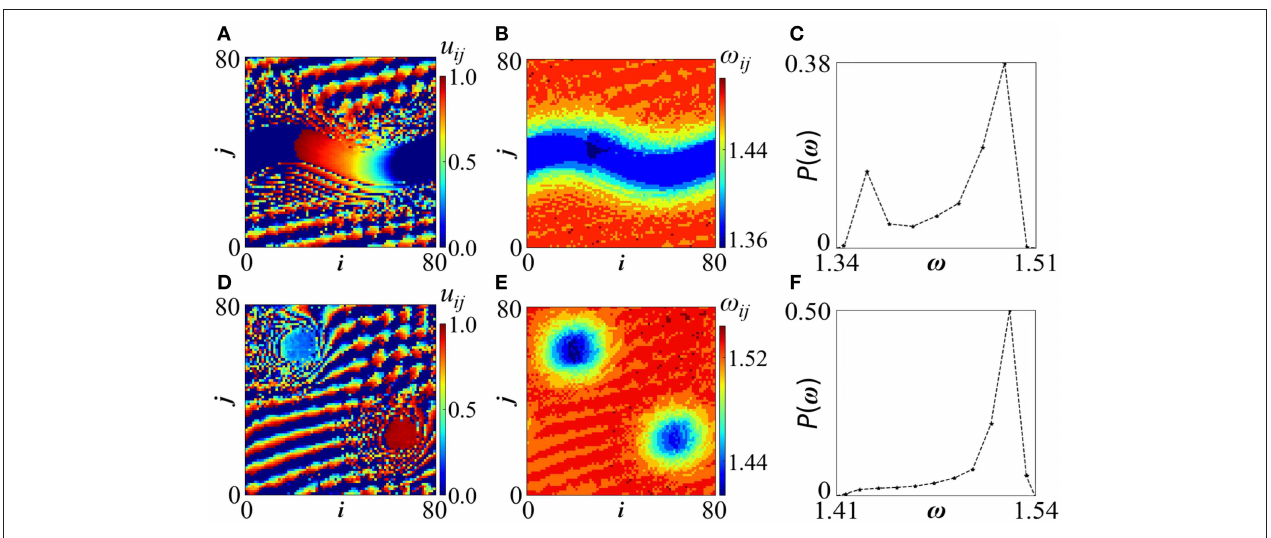
FIGURE 8 | Random hierarchical connectivity in LIF model. Top row: Stripe chimera for parameters σ = 0.22, T r = 2.0. (A) u ij -profiles, (B) ω ij -profiles and (C) distribution of ω -values. The P ( ω ) spectrum present two distinguishable maxima: one at the high ω -region which correspond to the traveling waves with short wavelength and one in the low ω -values associated with the stripe. Bottom row: Double coherent spot chimera for σ = 0.26 and T r = 2.0. (D) u ij -profiles, (E) ω ij -profiles and (F) distribution of ω -values. The P ( ω ) spectrum presents only distinguishable maximum at the high ω -region which correspond to the traveling waves with short wavelength. A peak in the low ω -values in (F) is not observable because the extent of the two coherent spots [“blue” regions in (E) ] is of similar size to the extent of the incoherent domains [“yellow” regions in (E) ] and therefore a plateau appears. The dashed lines in (C,F) serve as eye guides. All other parameters are as in Figure 2A . Simulations start from random initial conditions. Other related images are available in the Supplementary Material .